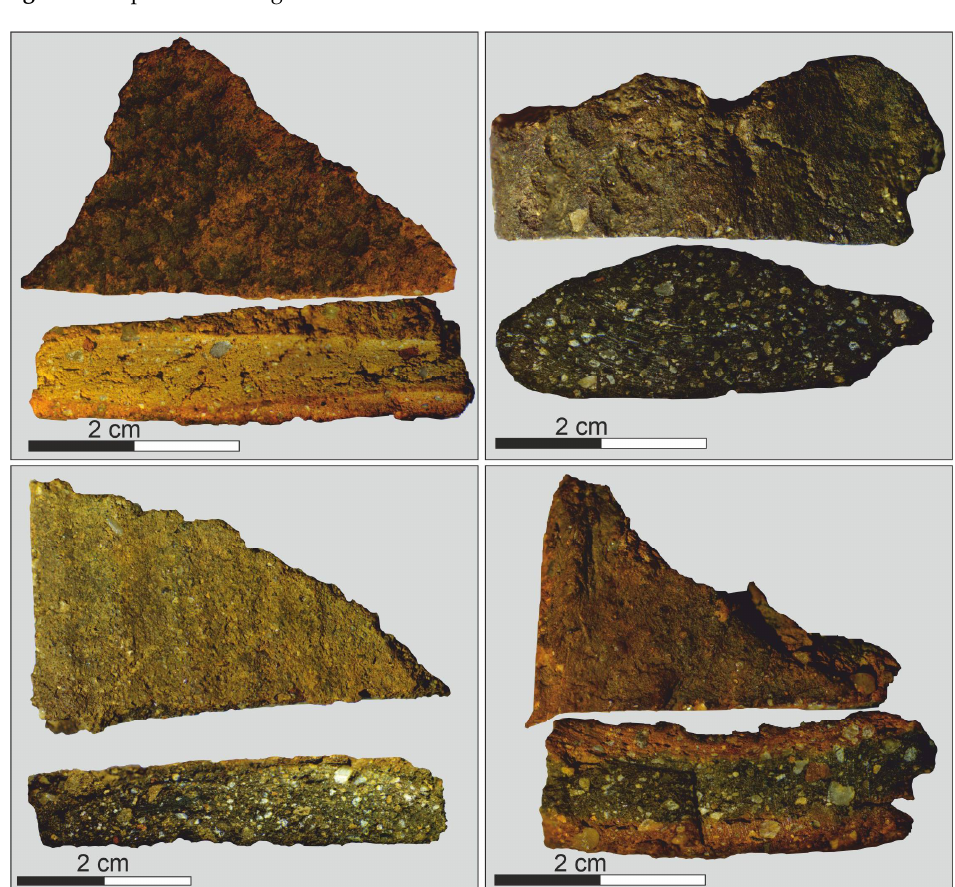
Figure 5. Examples of pottery sherds from eastern Siberia (Baikal